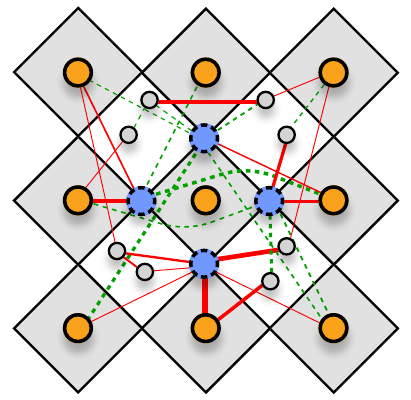
Figure 7: Architecture of a d = 3 NEAT decoder for bitflip noise, rotated with respect to Fig. 1 for convenience. The neuron inputs are placed where they are located on the lattice, as are the four outputs. The width of the edges are proportional to the corresponding absolute value of the weights. Positive (negative) weighting is shown with dashed green (solid red)